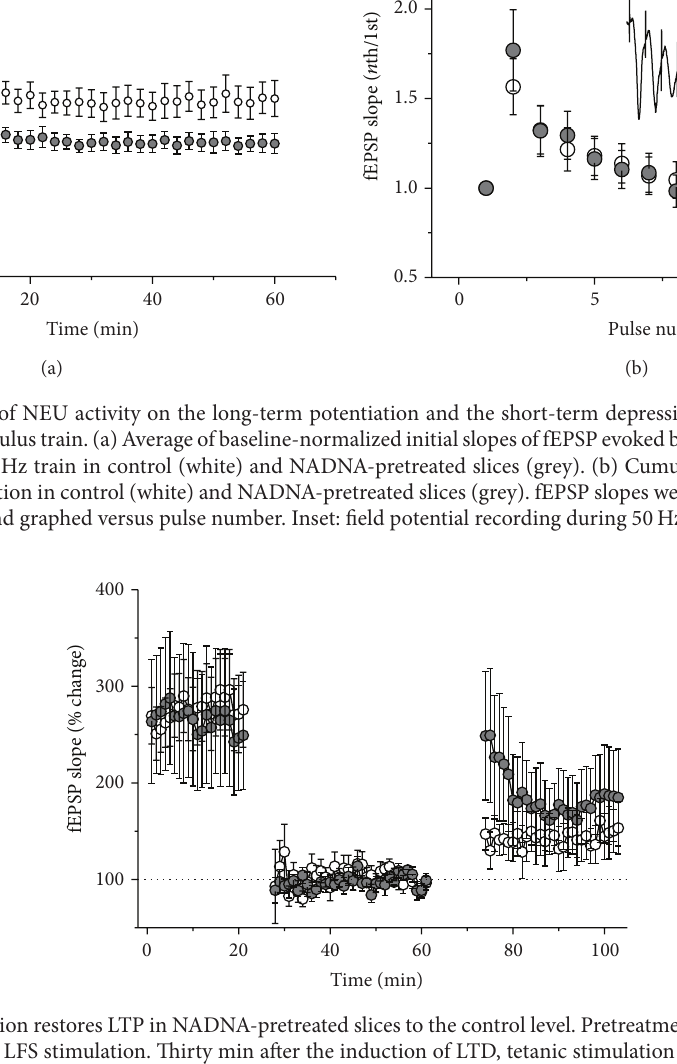
in response to continuous HFS than control slices.